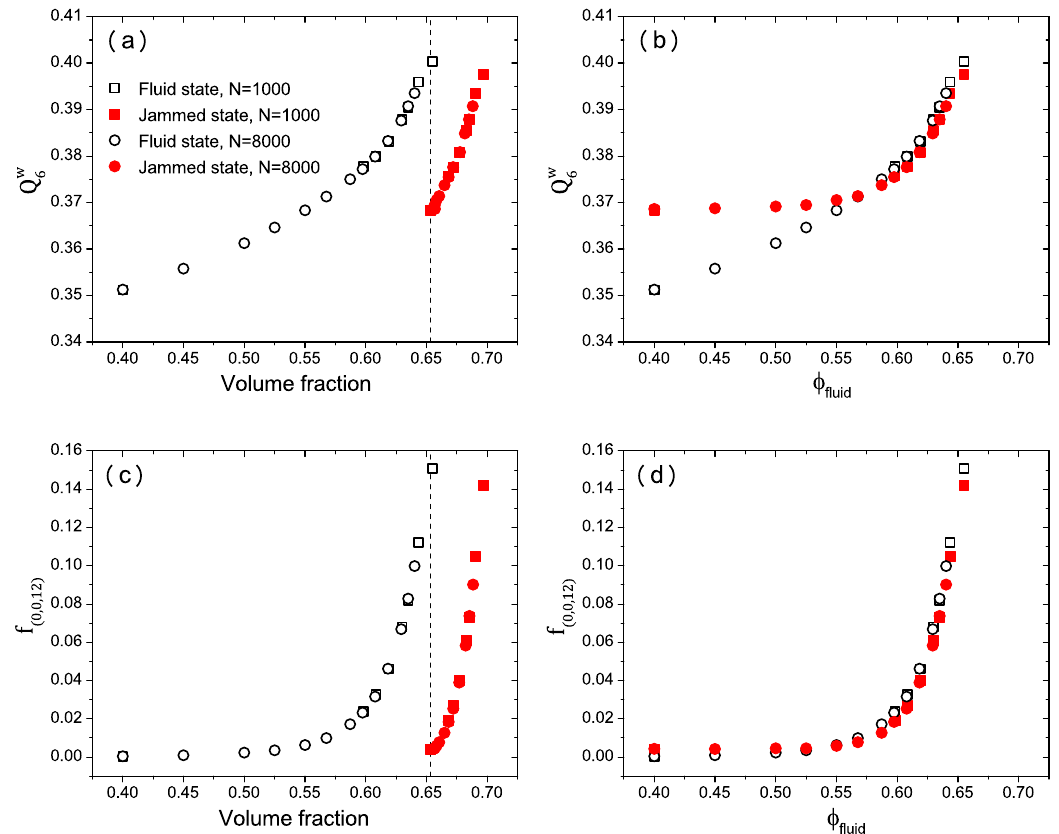
for the fluid and jammed states as 6 , (b). fluid